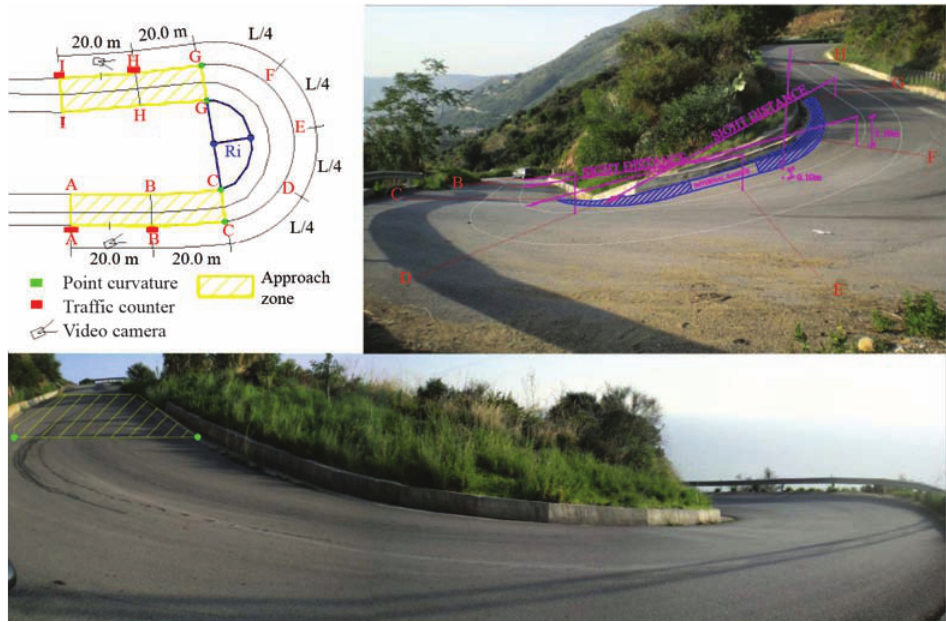
Fig. 4. Measuring sight